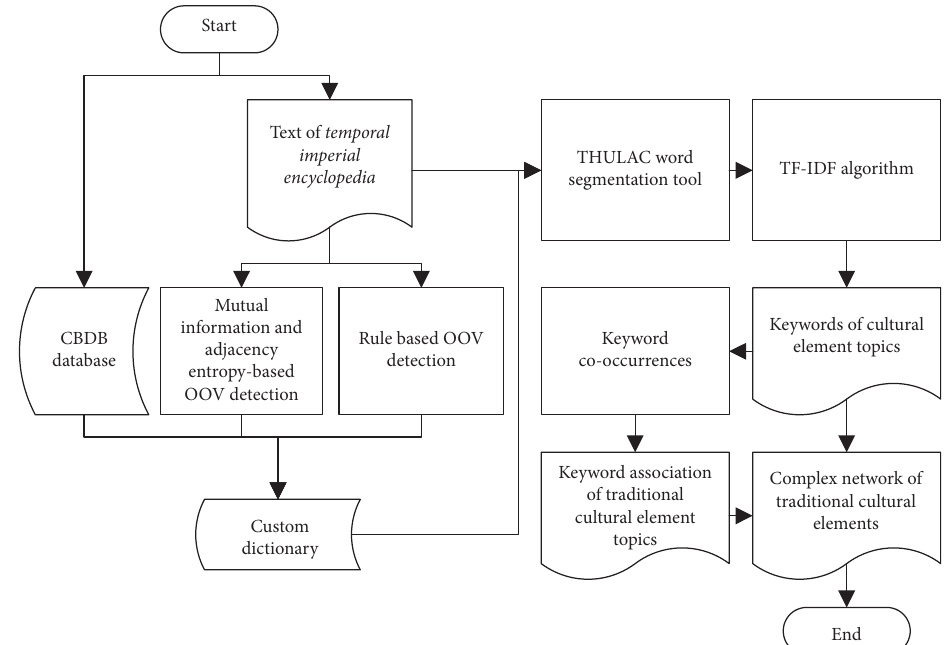
Figure 1: The construction process of the complex network of traditional cultural